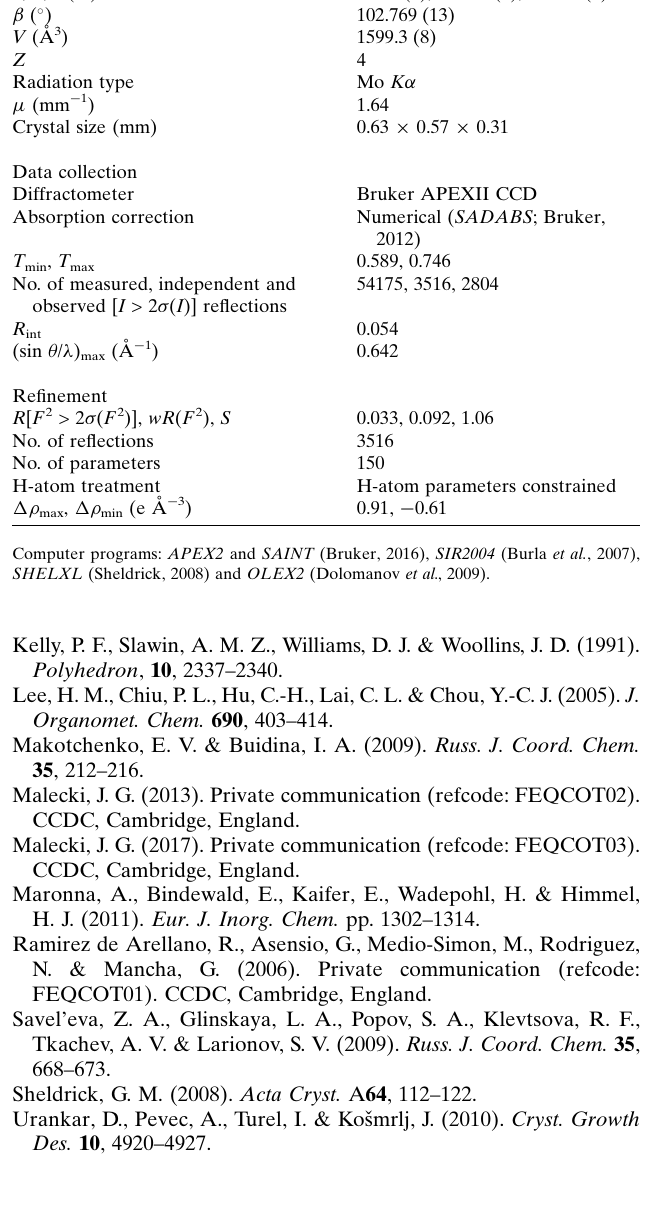
Figure 1 The title compound with displacement ellipsoids drawn at the 50% probability level. H atoms drawn as spheres of arbitrary